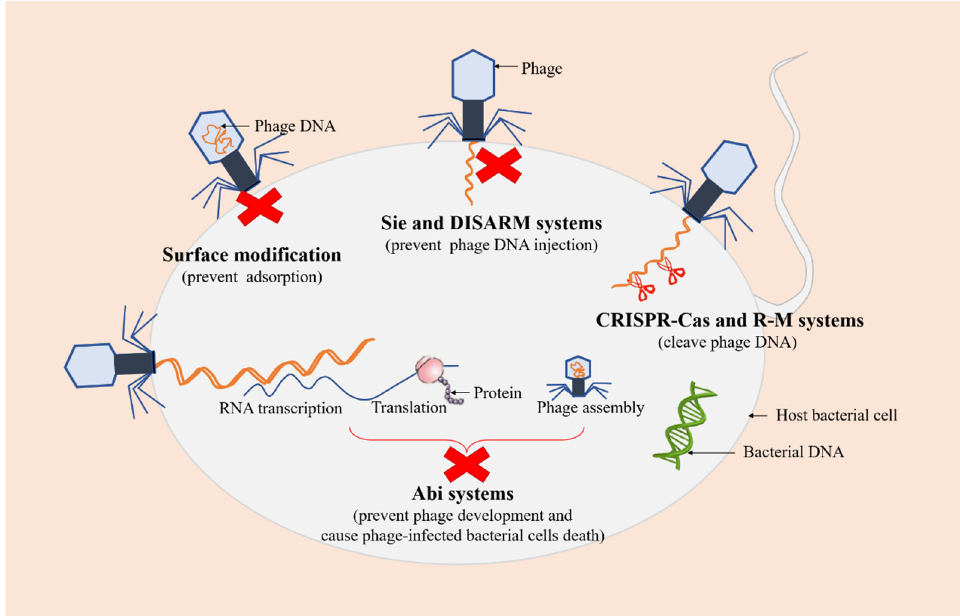
Figure 3. Several defense systems of bacteria against phages. The red crosses represent the arrest of the infection process. The green DNA molecule represents bacterial DNA. The orange DNA molecules represent phage DNA.